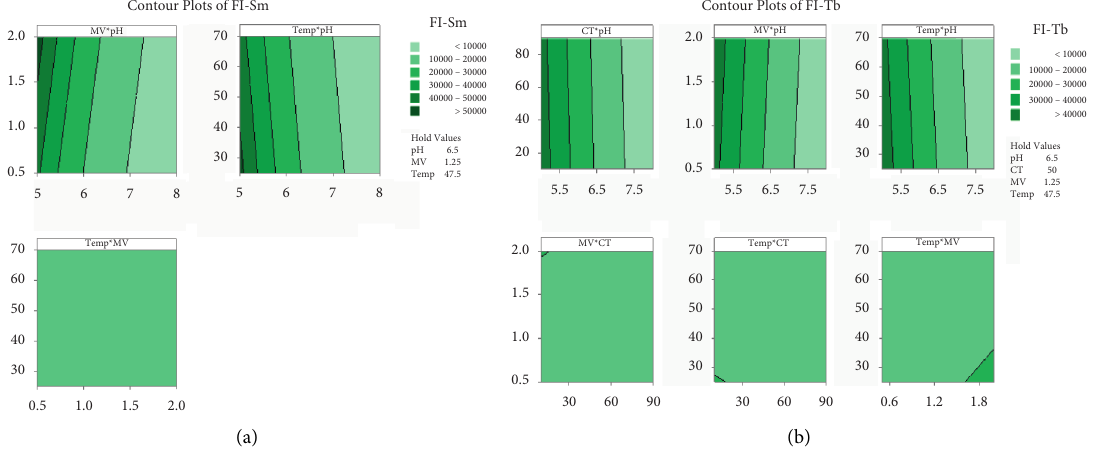
Figure 4: Two-dimensional contour plots for both ORLX-Sm(III) (a) and ORLX-Tb(III) (b).